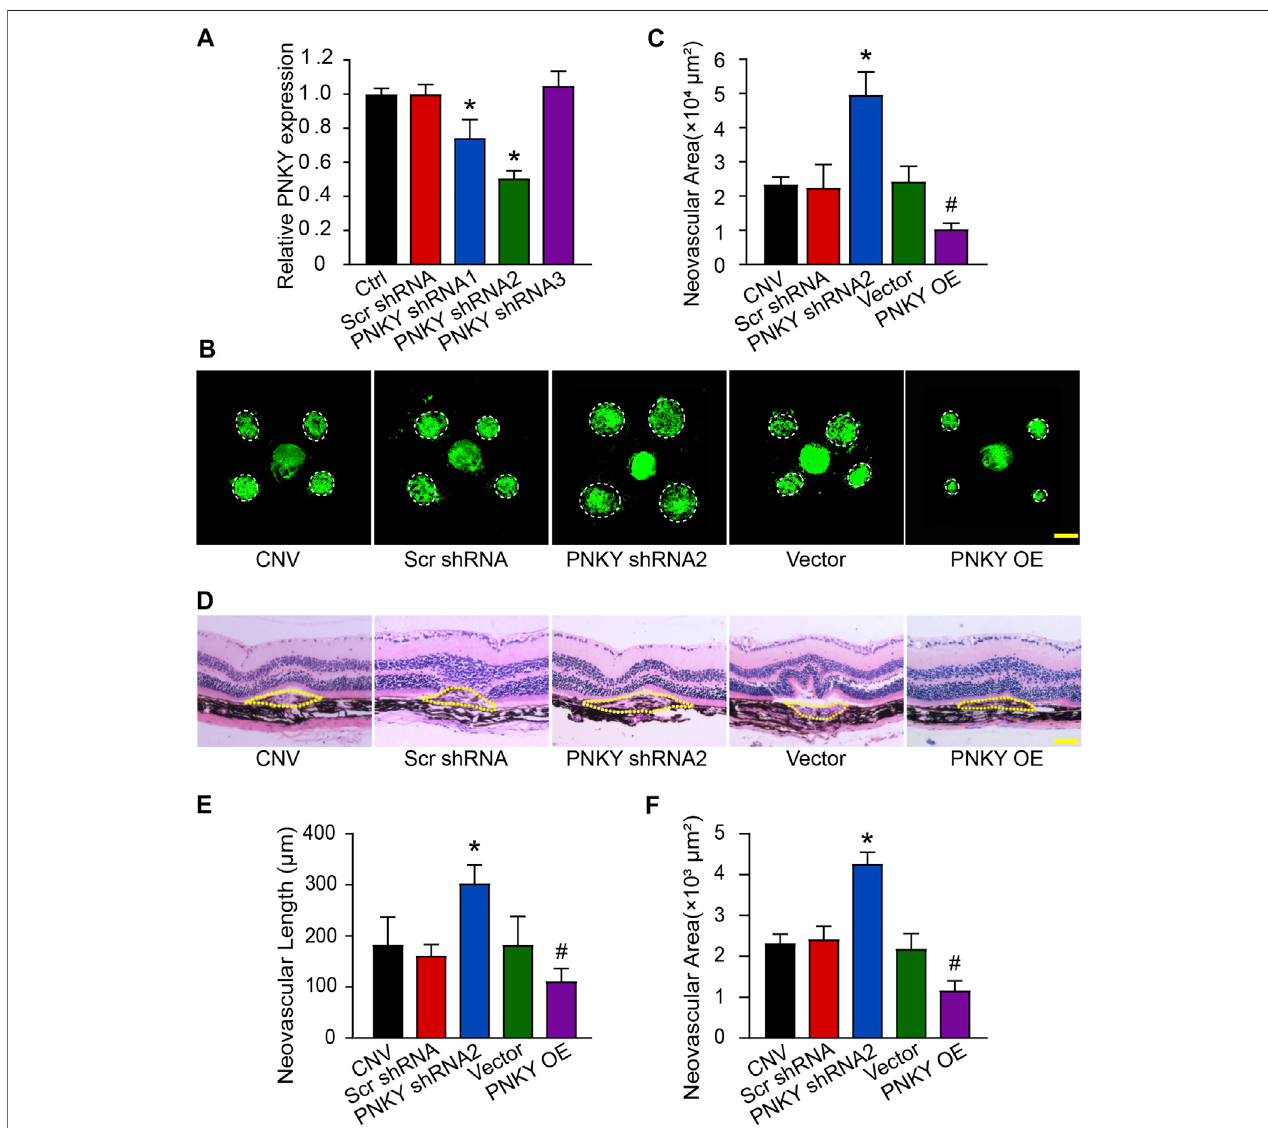
FIGURE 2 | LncRNA PNKY silencing promotes the development of laser-induced CNV in vivo . (A) Eight-week-old C57BL/6 mice were injected with scrambled (Scr)shRNA,PNKYshRNA,orleftuntreated(Ctrl).qRT-PCRswereimplementedtodetecttheexpressionofPNKYinthechoroidatday14( n =5). (B,C) Eight-week-old C57BL/6 mice received an intravitreal injection of scrambled (Scr) shRNA, PNKY shRNA2, vehicle (Vector), PNKY overexpression vector (PNKY OE), or left untreated (CNV)14daysbeforelaserphotocoagulation.CNVin fl attenedchoroidalorganizationsreceivedvisualizationby fl uorescentlabelingofIB4andquanti fi cationonday 7.Thelesionregionswerehighlightedbywhitecircles(Scalebar,100 μ m, n =5). (D) Sevendaysafterphotocoagulation,typicalimagesofhematoxylinandeosinstaining of cross sections of the CNV were displayed and quanti fi cation of the length (E) and the area (F) of the CNV was performed. Yellow dashed lines delineate the lesions (Scalebar,100 μ m, n =5).Allsigni fi cantdifferencewasevaluatedbyKruskal – Wallis ’ stestfollowedbyposthocBonferroni ’ stest.* p < 0.05versusScrshRNA,# p < 0.05 versus Vector.